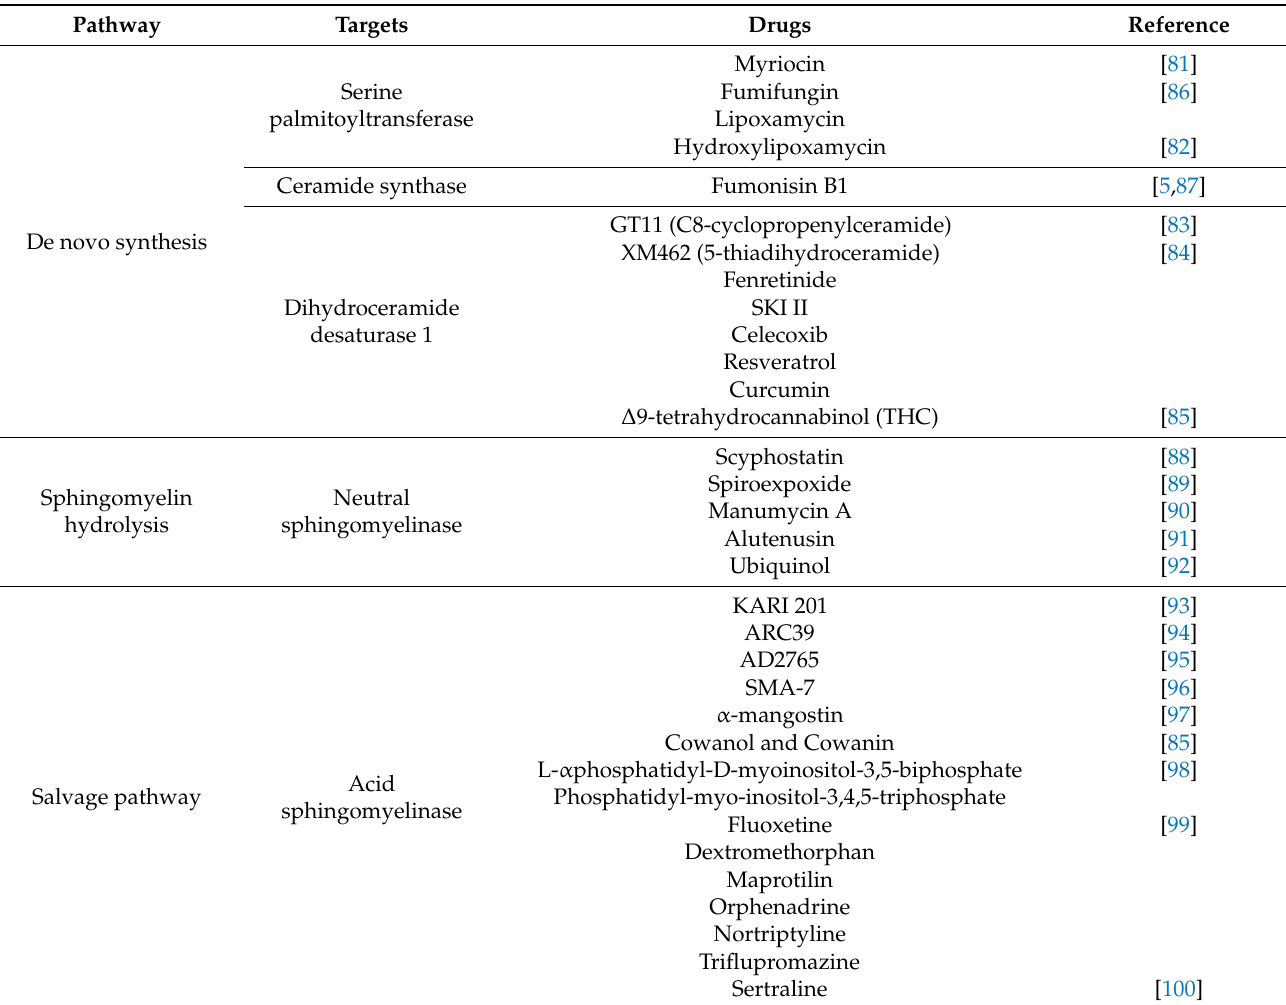
Table 1. List of drugs targeting different ceramide biosynthesis